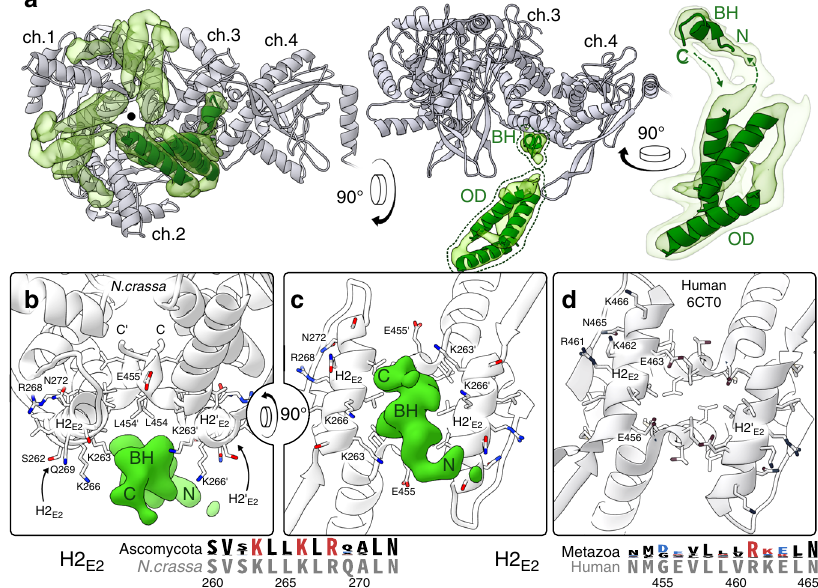
Fig. 2 The E2-pair interface constitutes a conserved basic/hydrophobic binding pocket. a E2 chains (gray) 1 – 3 form a threefold-symmetric oligomer, and each of them additionally forms a twofold-symmetric bridge to an adjacent E2 monomer (here labeled chain 4). A pocket inside each of these three twofold E2 bridges accommodates one binding helix (BH) of the threefold interior density (transparent green). The bulk of the interior density forms the oligomer domain (OD) that extends N-terminally from the BH. The OD is consistent with a three-helix bundle, although secondary structure and connectivity remain ambiguous. Helices of ~20 residues are docked to illustrate this (green cartoon). b The BH binds asymmetrically to the symmetric pocket formed by the E2 bridge (Supplementary Fig. 3). c A rotated view shows that in Ascomycota, pocket-lining lysines in H2 E2 are conserved (sequence logo). d In contrast, the human E2 interface is less basic and conserved, apart from residues involved in substrate interaction